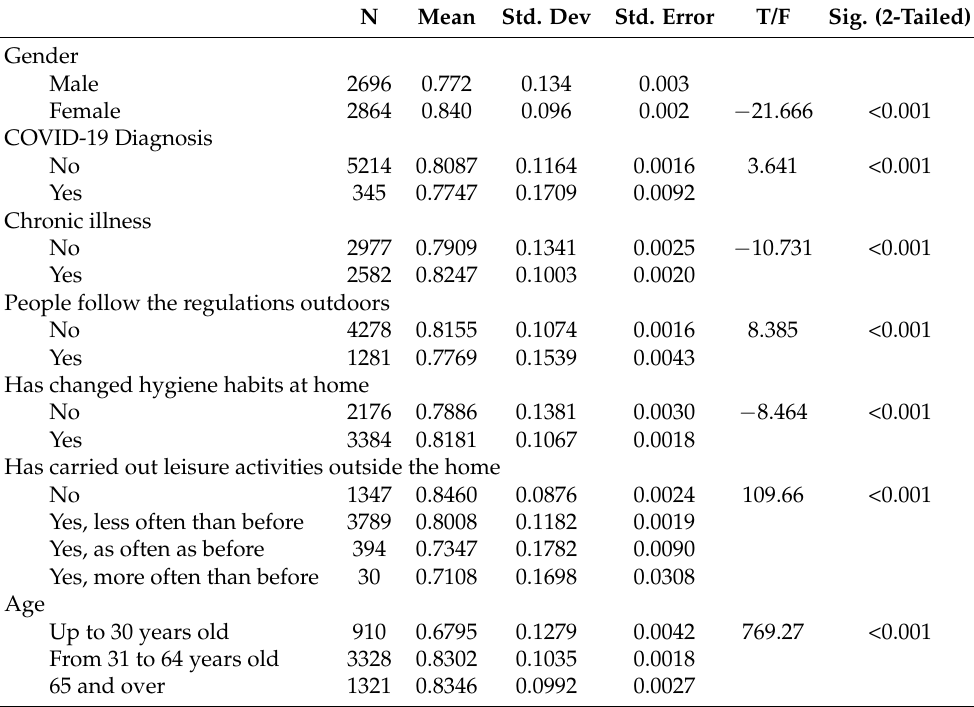
Table 5. Comparison of means of the probability of fear of infection of specific subgroups (ANOVA). N Mean Std. Dev Std. Error T/F Sig.